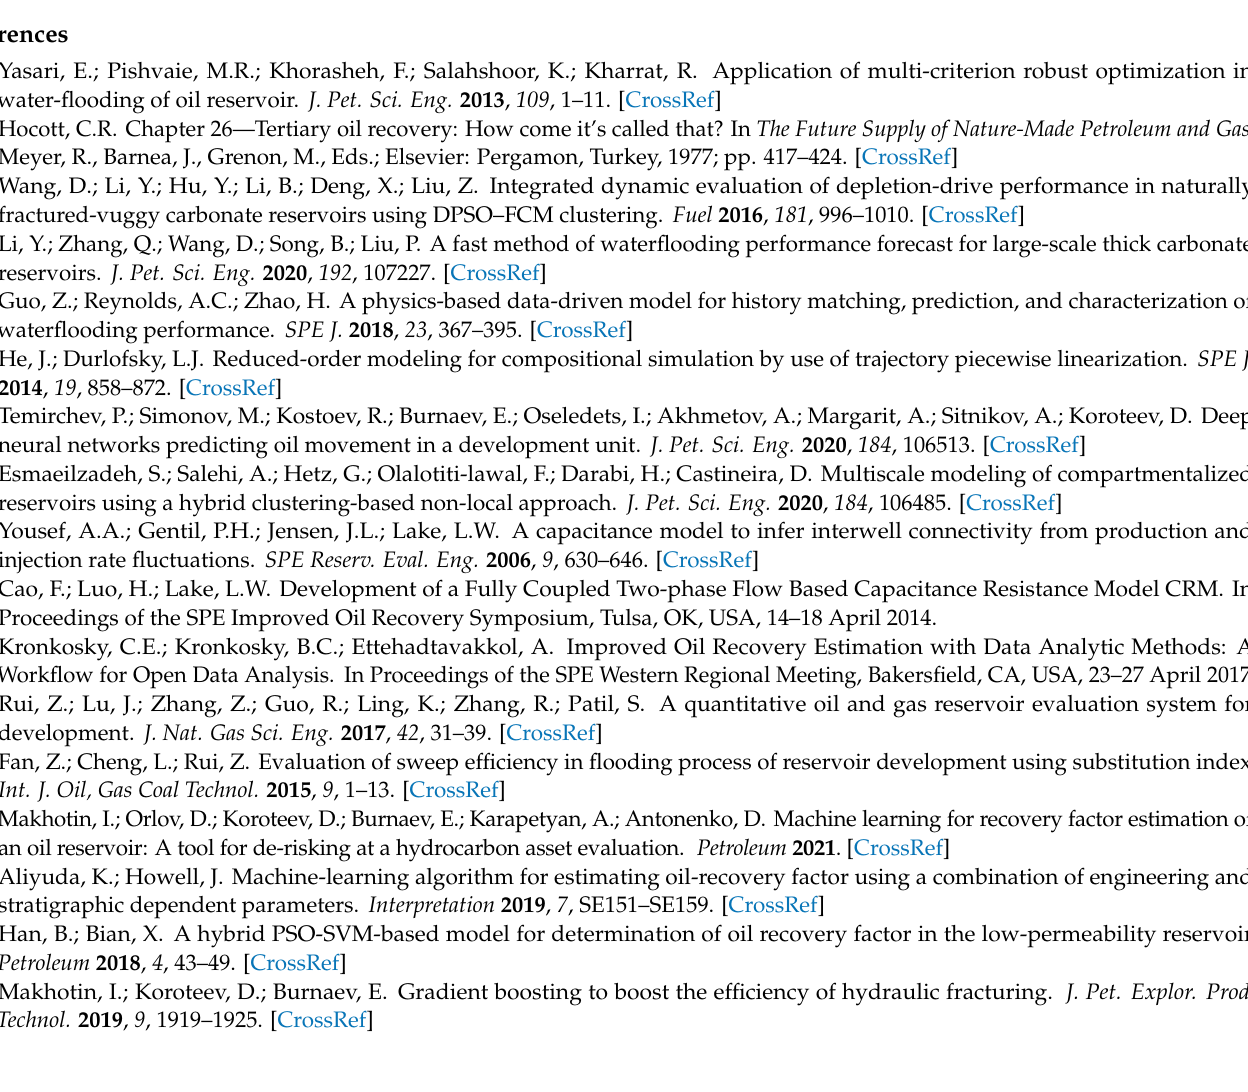
Figure A2. Input vs. target parameters Pearson correlation coefficients